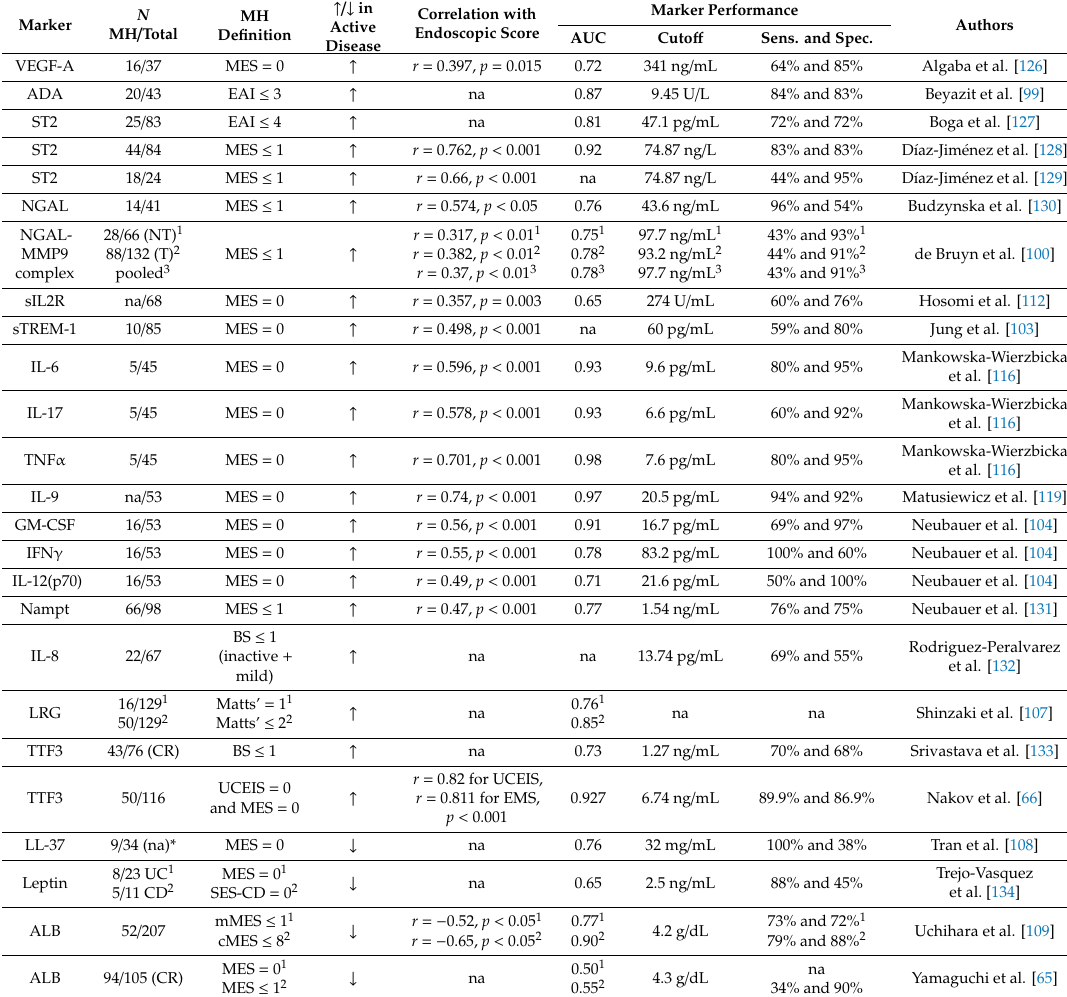
Table 8. Diagnostic performance of other serum-based markers in MH detection for ulcerative